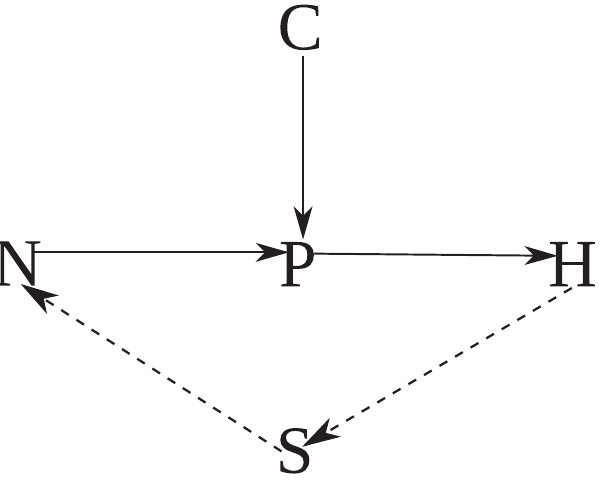
Fig 9. Proposed causal diagram of the factors that lead to partitioning. N = Population density, P = productivity, C = climate variation, H = Harvest, and S = Strategy.